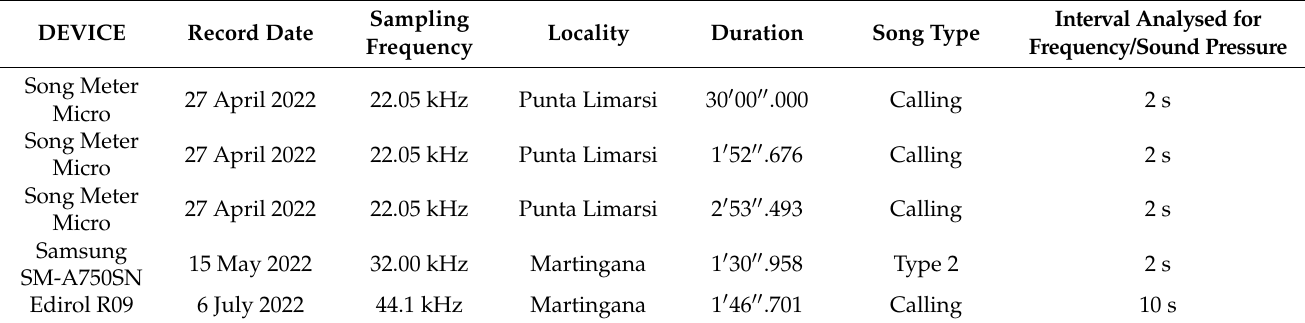
Table 2. Details about the audio samples used for the